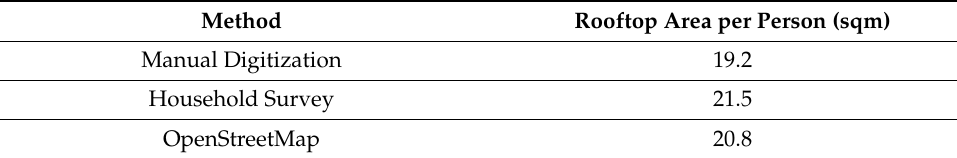
Table 3. Rooftop area per person from different